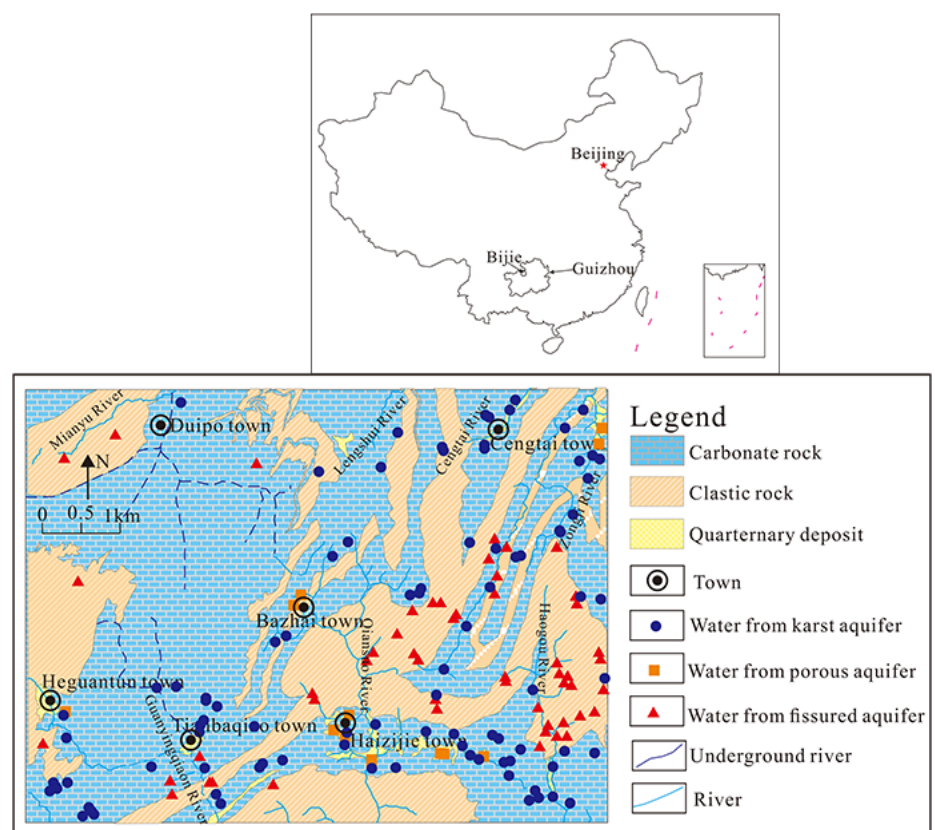
Figure 1. The geological setting map and sampling locations in the study area.